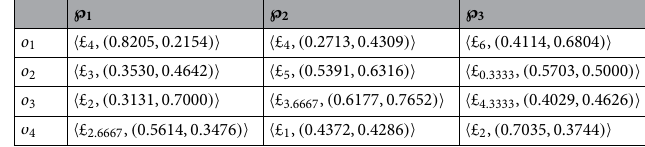
Table 7. Collective decision matrix.